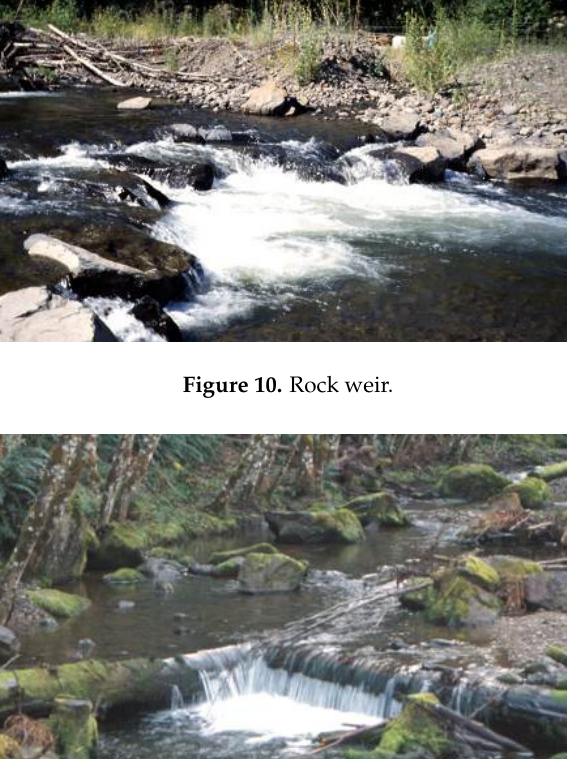
Figure 11. Log weir.